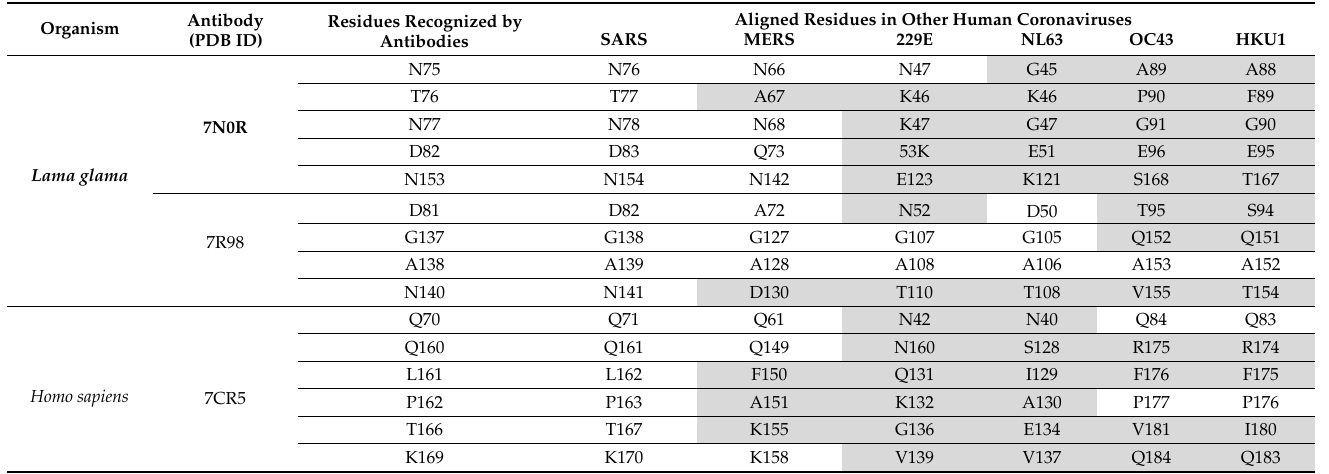
Table 4. Conservation of SARS-CoV-2 N protein amino acids recognized by nanobodies (7R98 and 7N0R) and the antibody 7CR5 across other human